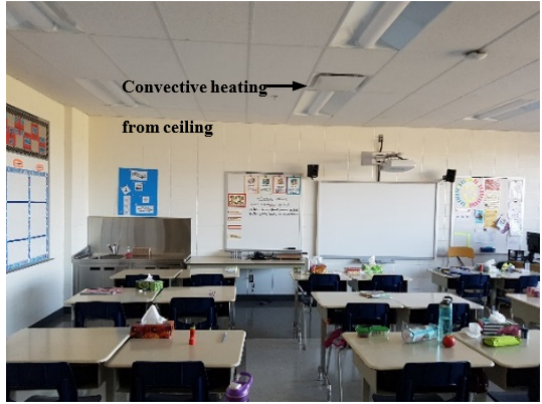
Figure 4. Typical classroom with convective heating.